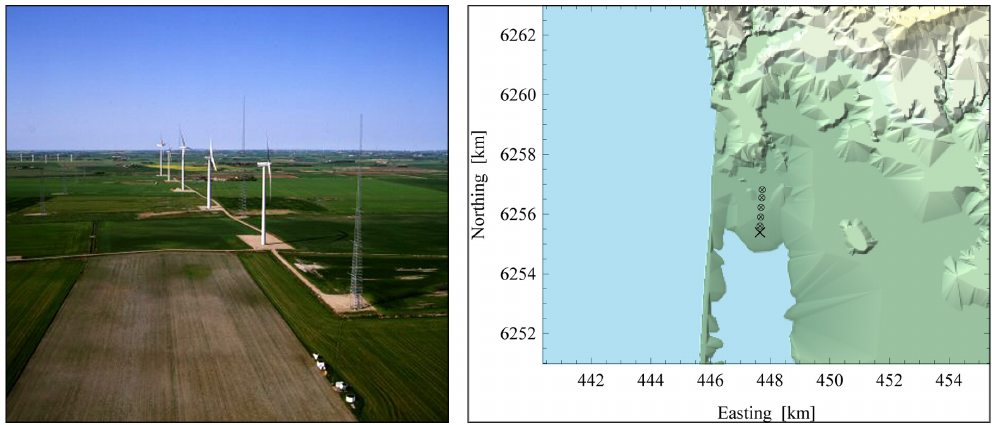
Fig. 2. Photo and map of the Høvsøre site. In the foreground of the photo, a row of lidars and sodars can be seen. However, the lidar utilized in this study was located approximately 20m to the north of the mast. The highest point of the map represents a height of 50m, whereas the mast (cross) and turbines (circles) are located only a few meters above sea level.